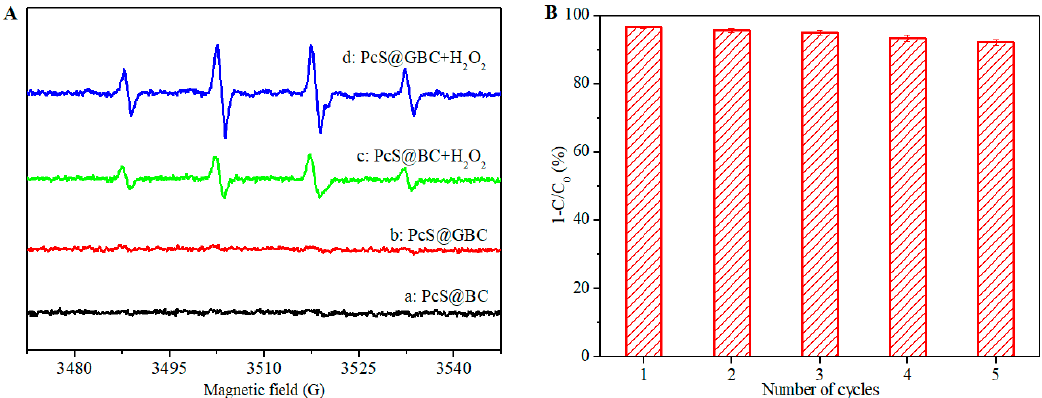
Figure 9. ( A ): EPR spectra of dye solution with existence of a: PcS@BC, b: PcS@GBC, c: PcS@BC–H 2 O 2 , and d: PcS@GBC–H 2 O 2 . ( B ): Cycling experiments of catalytic oxidation of dye solution (initial concentration = 100 μ M, pH = 2, T = 50 ° C, reaction time = 90 min) with PcS@GBC (0.75 mg) and H 2 O 2 (10 mM).